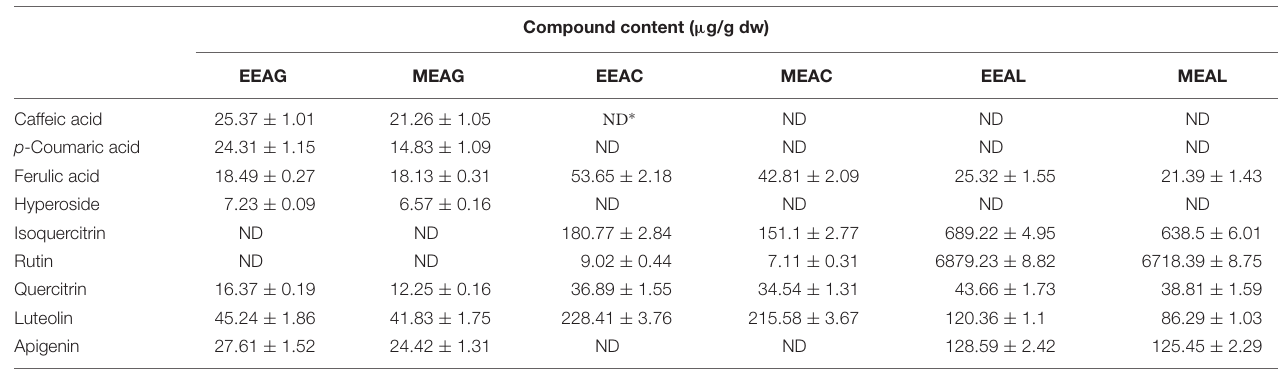
TABLE 2 | Polyphenolic profile of A. genevensis (AG), A. chamaepitys (AC), and A. laxmannii (AL)